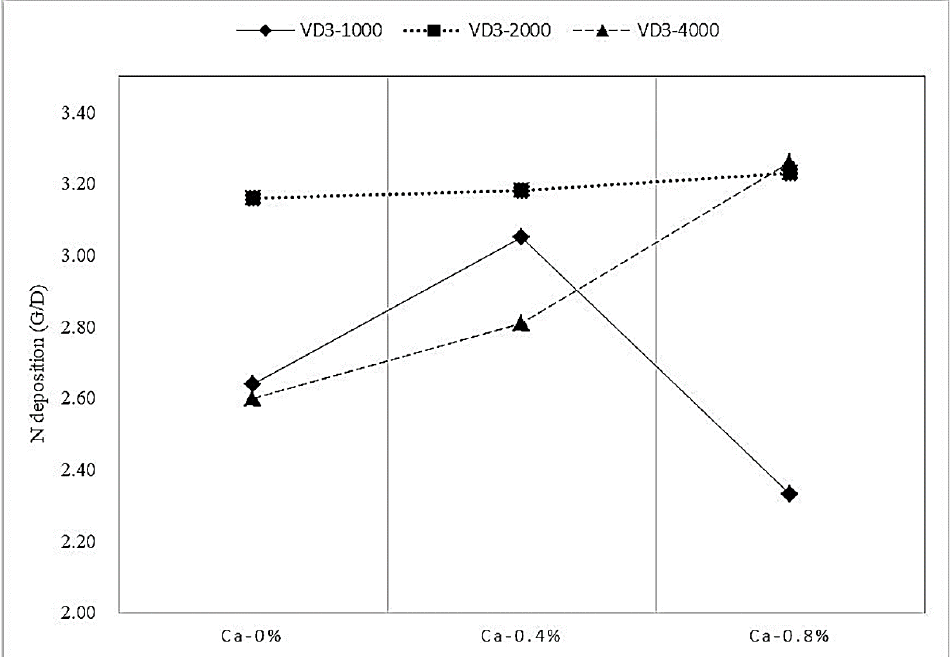
Figure 1. The effect of the interaction between Ca and VD 3 on N deposition in growing blue foxes. VD 3 = vitamin D 3 . N = nitrogen.